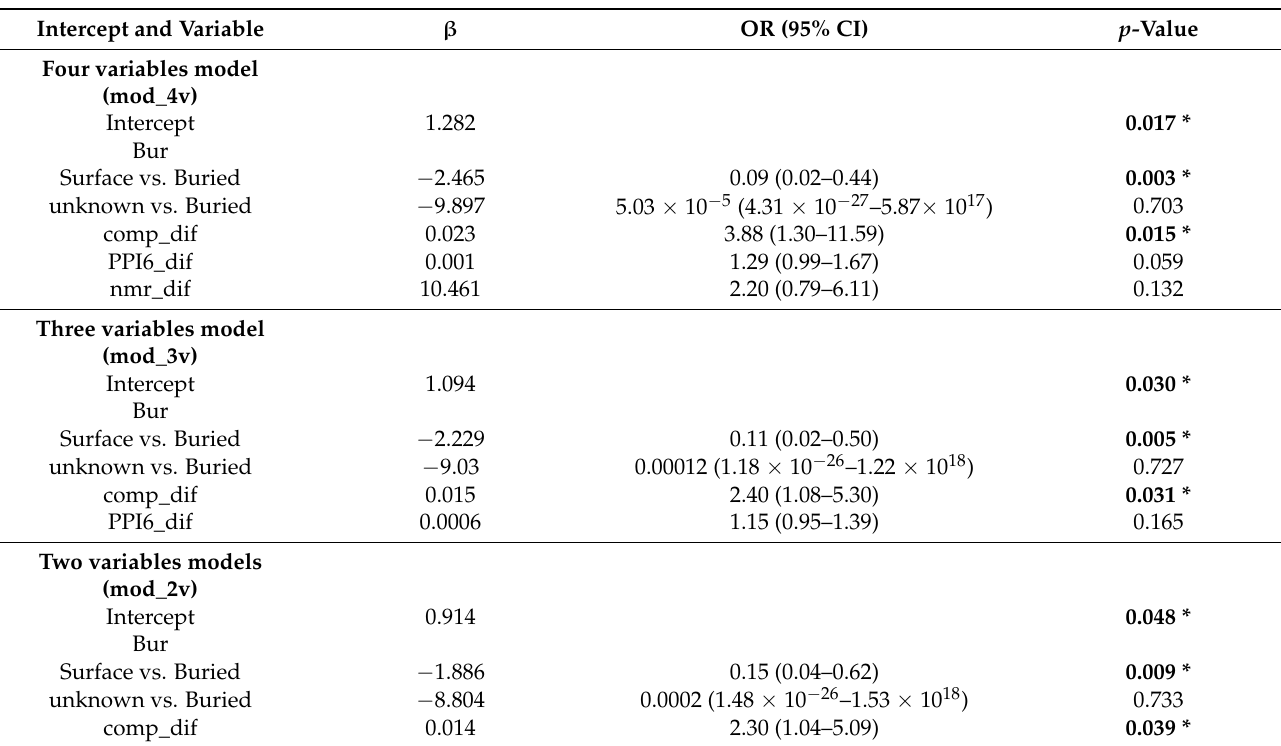
Table 2. Reduced models for multivariate logistic regression analysis of disease